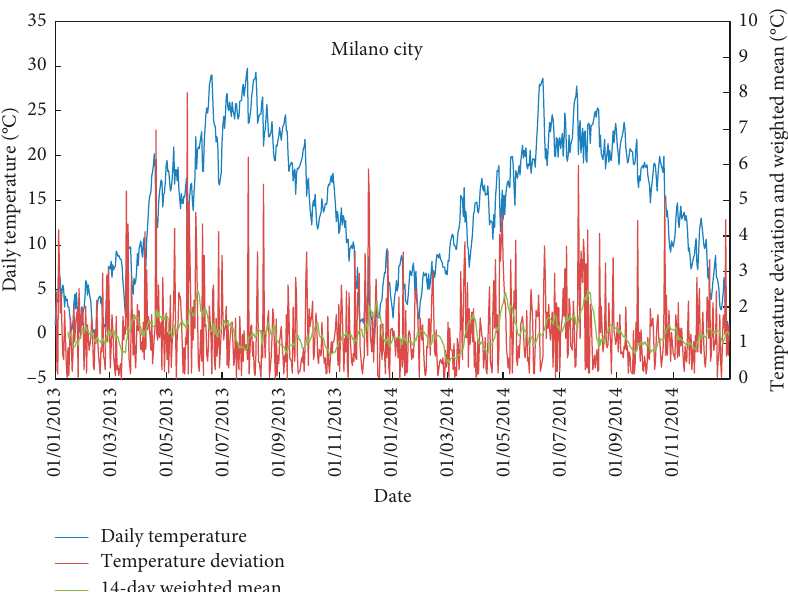
Figure 4: Observed daily temperatures (blue line) and deviations (red line) with the 14-day weighted mean (green line) over the analysed dataset: an example of the Milano